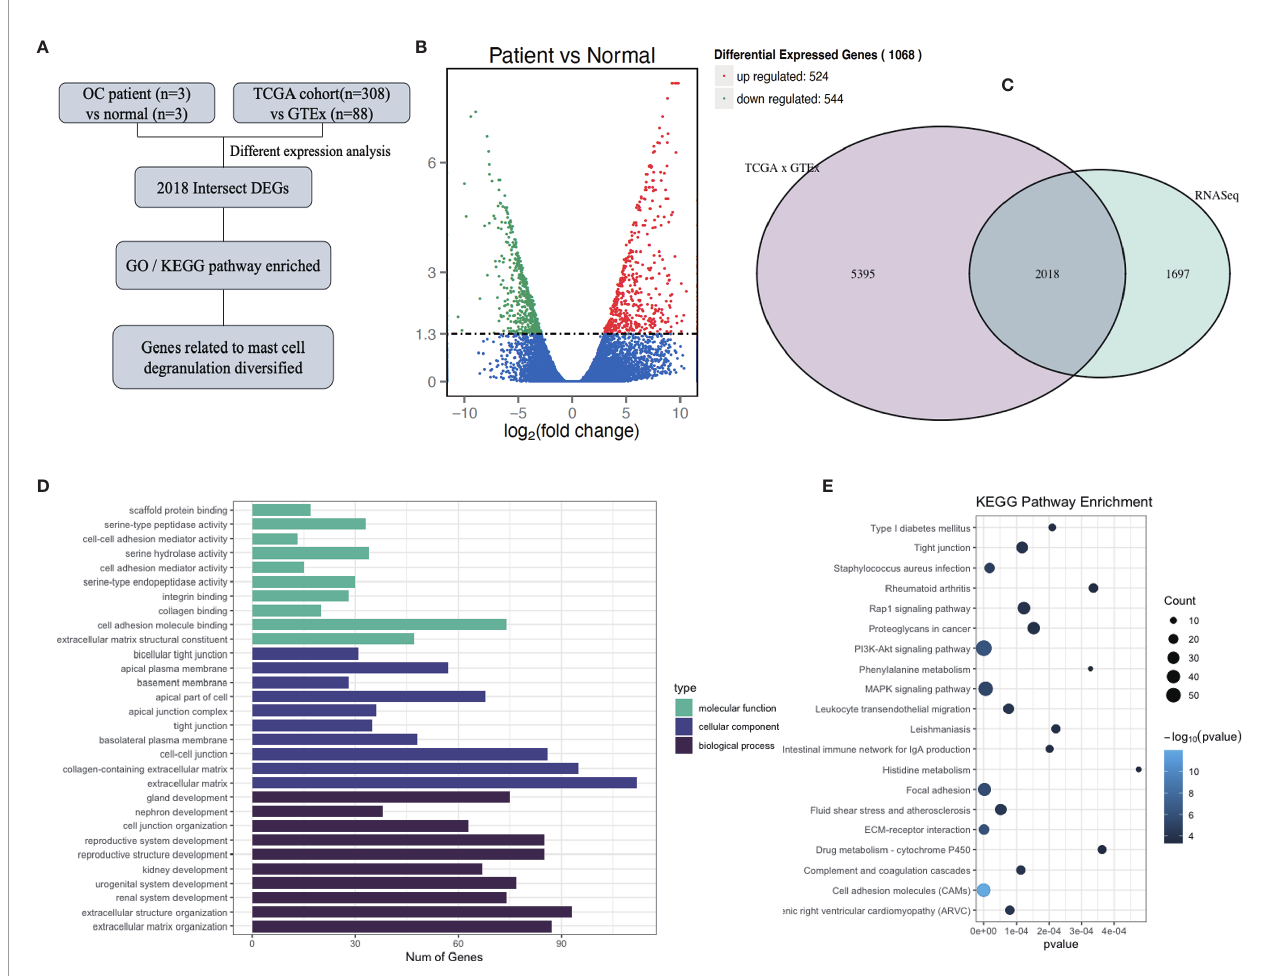
FIGURE 1 | Determination of genes differently expressed between normal ovarian tissue and ovarian cancer tissue. (A) Flow diagram of current bioinformatics research: a combination of RNA-Seq analysis and TCGA database. (B) Volcano plot of all genes differentially expressed between normal ovarian tissue (n = 3) and ovarian cancer tissue (n = 3), at a signi fi cance thresholds of |log2(Fold Change)| > 1, P adj<0.05. (C) Venn diagram of the results of the analyses of RNA-Seq and differently expressed genes (DEGs) in TCGA and GTEx. (D, E) GO (D) and KEGG (E) enrichment pathway analysis involving intersection